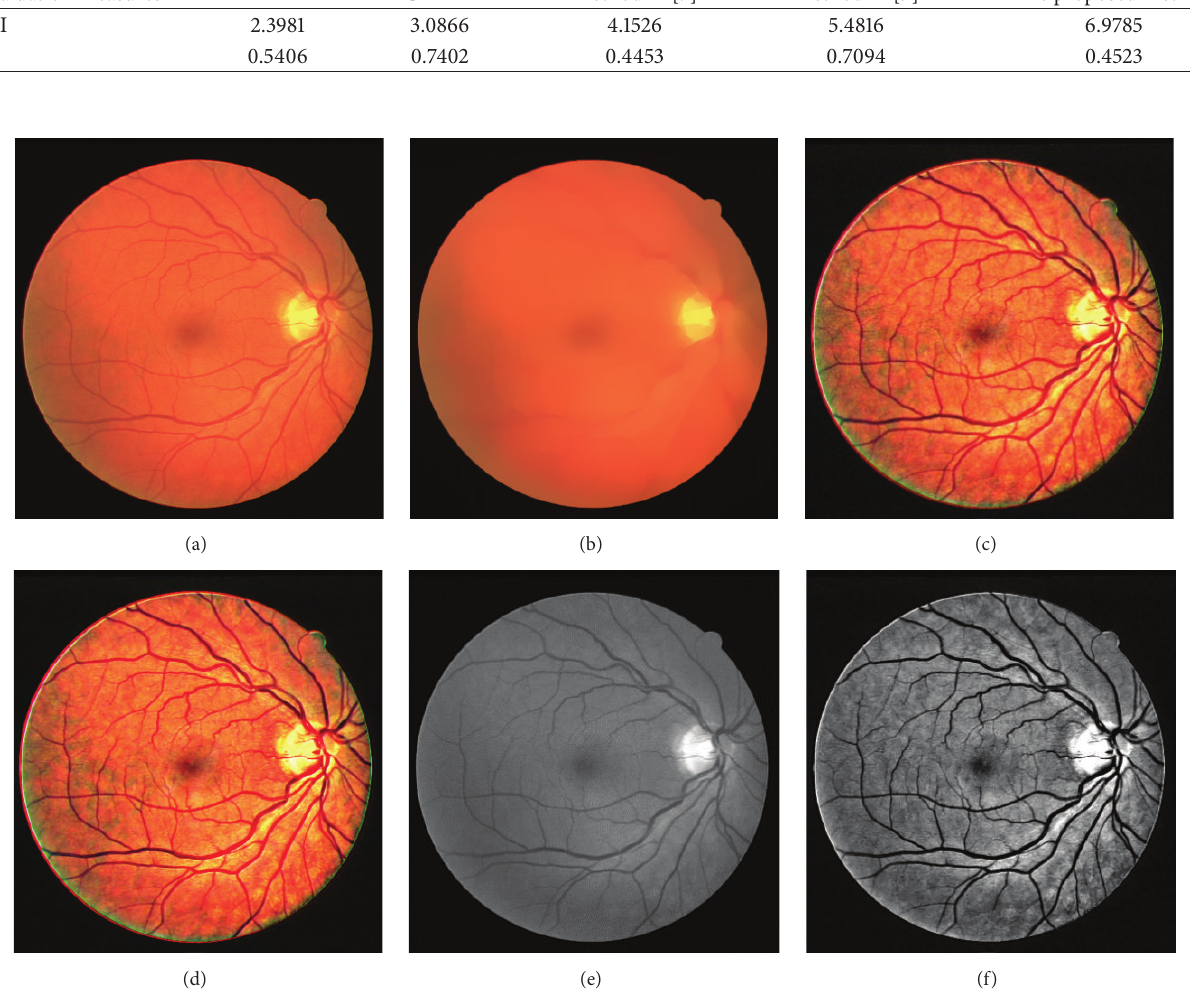
Figure 3: The enhancement process of the chosen retinal image from the DRIVE database. (a) Original image; (b) normalized convolution result; (c) fusion result; (d) denoising result; (e) green channel of original image; (f) green channel of denoising result.